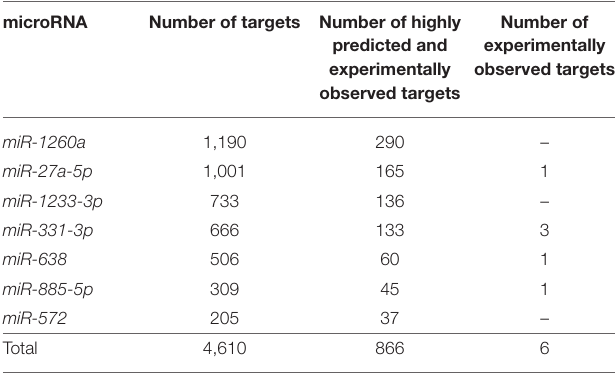
TABLE 2 | Number of targets of the microRNAs comprised in the OT vs. CR differential profile . microRNA Number of targets Number of highly